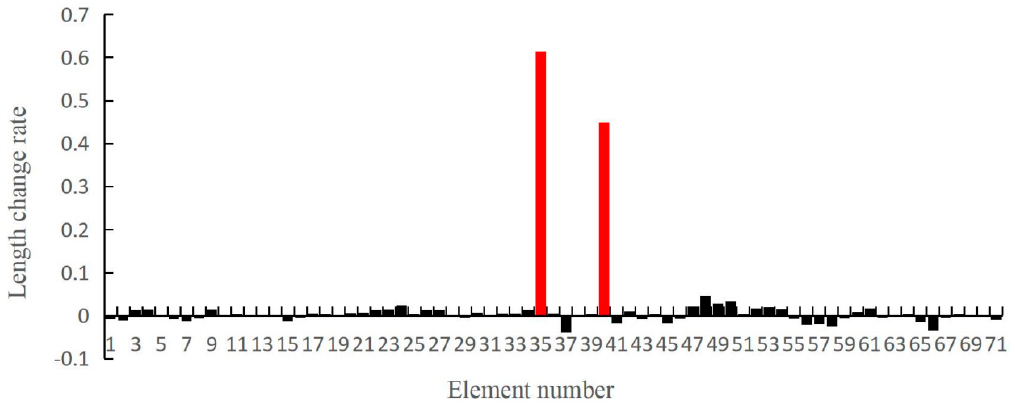
Figure 9. Length change rate of element obtained from the dynamic data (elements 35 and 40 were damaged with no noise).